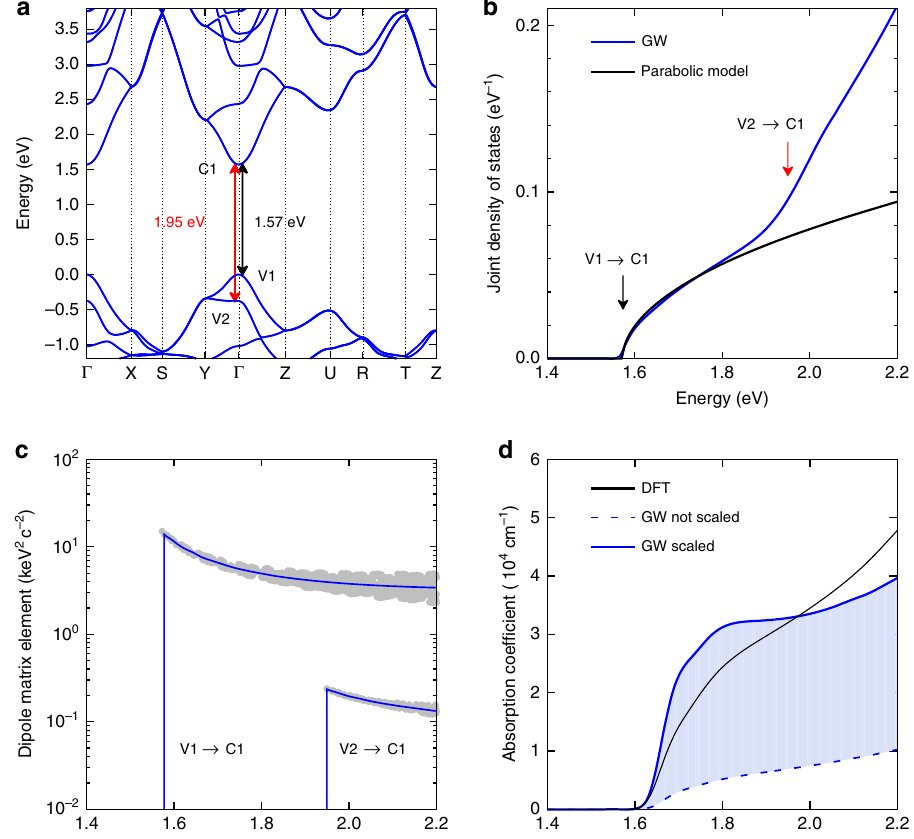
Fig. 2 First-principles calculations of CH 3 NH 3 PbI 3 . a Quasi-particle band structure of CH 3 NH 3 PbI 3 calculated using the GW approximation (see Supplementary Information for details). The black arrowed line shows the direct band transition from the fi rst valence band (V1) to the fi rst conduction band (C1) at an energy of 1.57 eV. The red arrowed line shows the transition from the second valence band (V2) to C1, at an energy of 1.95 eV. b The joint density of states derived from GW calculations (blue line), compared with the function expected from a simple parabolic band model (black line). The two arrows mark the two lowest energy transitions corresponding to those marked in a . c The electric dipole transition matrix element for the V1 ↔ C1 and V2 ↔ C1 transitions. Grey fi lled circles represent the matrix element as calculated at different k -points in the Brillouin zone using Eq. (3) of the Supplementary Information. The blue lines show the value averaged over all directions in the Brillouin zone. d Absorption coef fi cient spectrum calculated from density-functional theory (DFT) calculations (black), and GW calculations (blue) within the independent-particle approximation (i.e., without considering electron-hole Coulomb interactions). We report results using scaled (solid) and unscaled (dashed) dipole matrix elements, as derived using Eqs. (4) and (5) given in the Supplementary Information. The light blue region represents the uncertainty in the magnitude of the optical absorption spectrum owing to the approximate calculation of the dipole matrix elements. The functions have been shifted along the energy axis to make the onset coincide with the experimental value of E